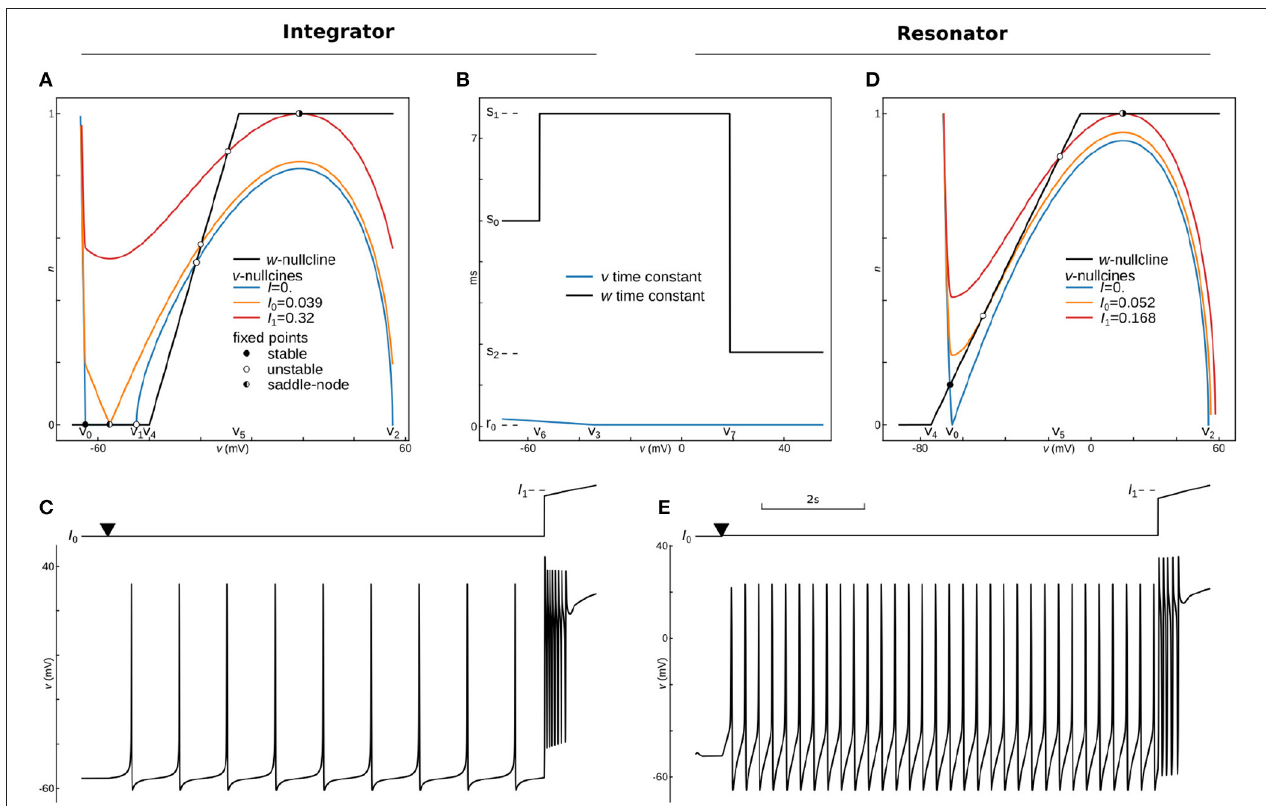
FIGURE 4 | Phase-Plane Analysis and dynamics for phenomenological models of Integrating and Resonant neurons. Phase-portrait (A) and time constants (B) for the integrator model with parameters: v 0 = − 65 mV, v 1 = − 45 mV, v 2 = 55 mV, a 0 = 3.5 10 − 6 , a 1 = − 10 − 4 (mV) − 1 , v 3 = − 35 mV, r 0 = 0.04 ms, r 1 = − 0.004 ms/mV, v 4 = − 40 mV, v 5 = − 5 mV, v 6 = − 55.45 mV, v 7 = 18.78 mV, s 0 = 5 ms, s 1 = 7.6 ms, s 2 = 1.8 ms, k = 2. Voltage nullclines are shown for zero current at resting (blue curve), for saddle-node bifurcation at the onset of pacing ( I 0 , yellow curve), and for saddle-node bifurcation at the onset of depolarization block ( I 1 , red curve). (C) Protocol ( top ) and voltage trace ( bottom ) of integrator dynamics. The model was held almost at the bifurcation point ( I 0 ) for 500 ms, and then the applied current slightly increases at the point marked by triangle for 9 s. At the last second, a ramp of the input current traverses from 0.9 I 1 to 1.1 I 1 to show the depolarization block.